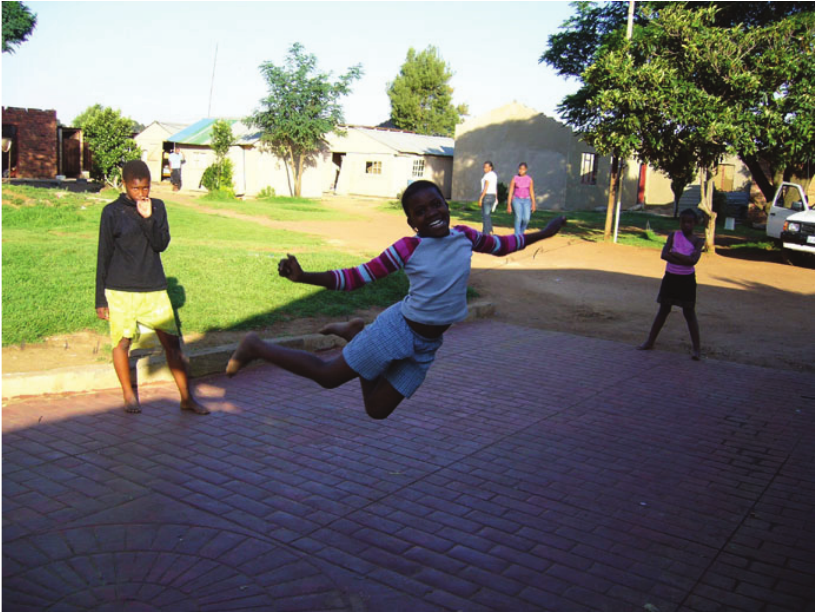
Photo 2: Children playing at Sithabile drop-in centre, eastern Gauteng. (http://www.